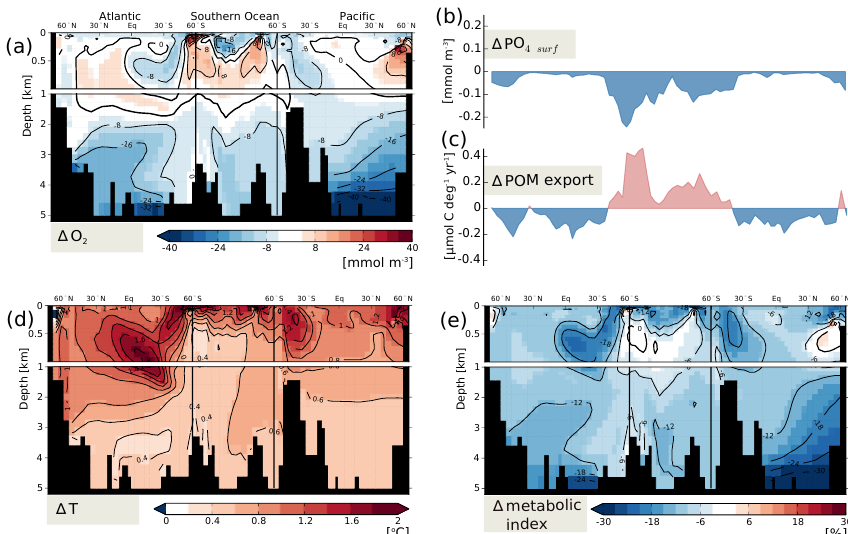
Figure 4. Changes in potential ecosystem stressors at peak O 2 decline (AD3150) relative to preindustrial steady state for a single represen- tative ensemble member reaching the 1.5 ◦ C warming target. Results are displayed for a cross section through the Atlantic (25 ◦ W), across the Southern Ocean (58 ◦ S) and into the Pacific (175 ◦ W). Changes in POM export at 75m (c) and in surface PO 4 concentrations (d) are displayed along the same